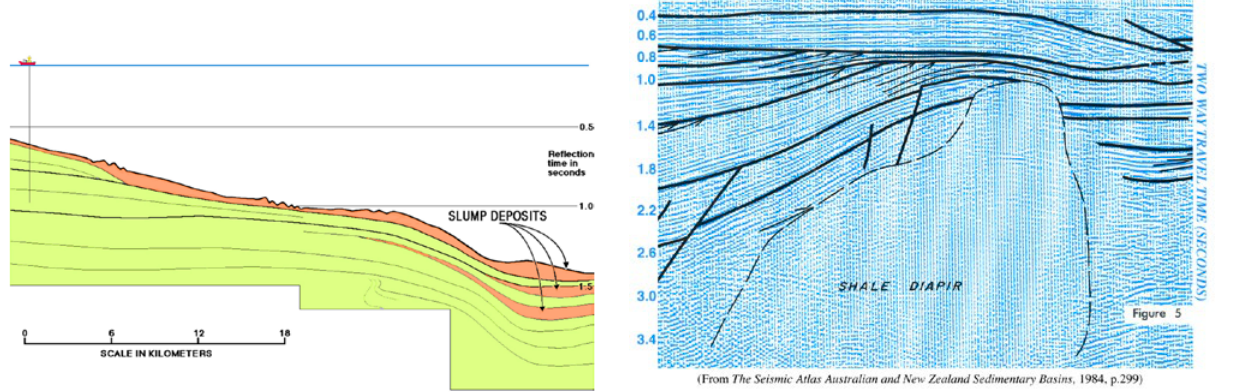
Figure 34. Massive submarine slope failure involves liquefaction of large volumes of sediment. Lehner 12 , 1969, fig. 45.